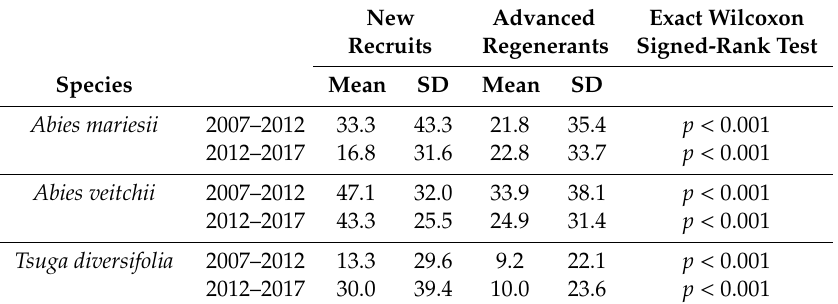
Table 3. Comparisons of maximum bark stripping ratio between new recruits and advanced regenerants (%).